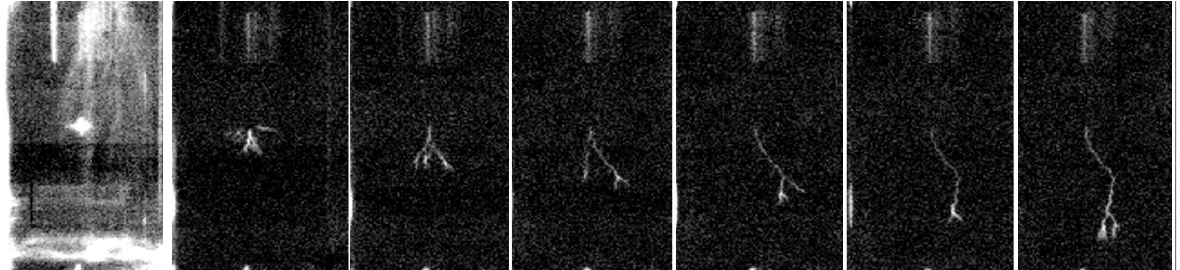
Figure A4. 0.35% DEA in cyclohexane, positive polarity, 238 kV. 5 µs between frames, Time-To- Breakdown (TTB) ≈ 40 µs.